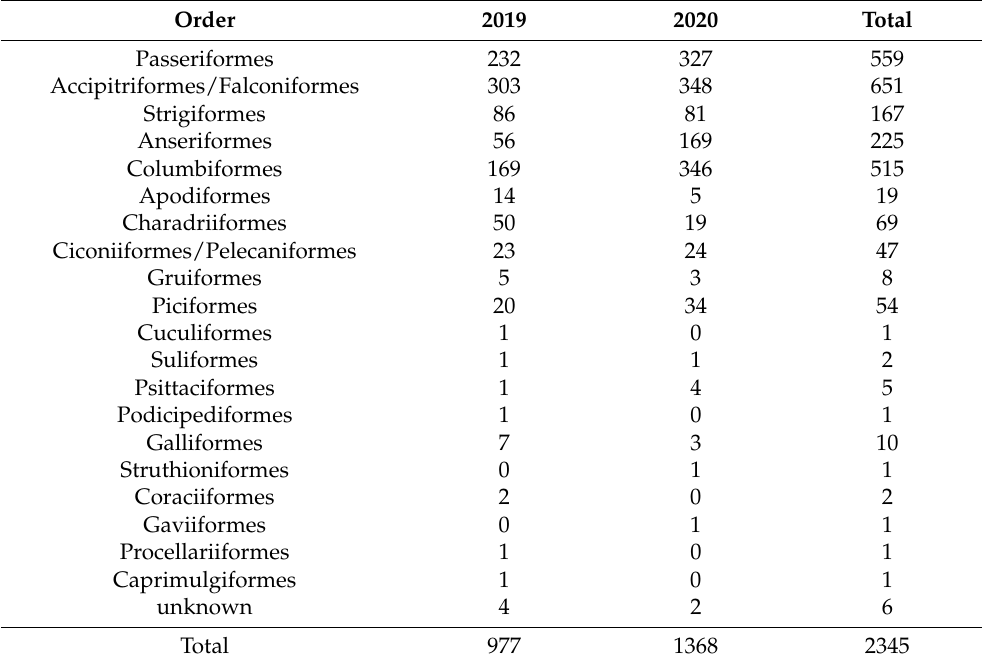
Table 1. Wild bird blood samples from Germany from 2019 to 2020 (first monitoring panel from live birds), grouped by taxonomic